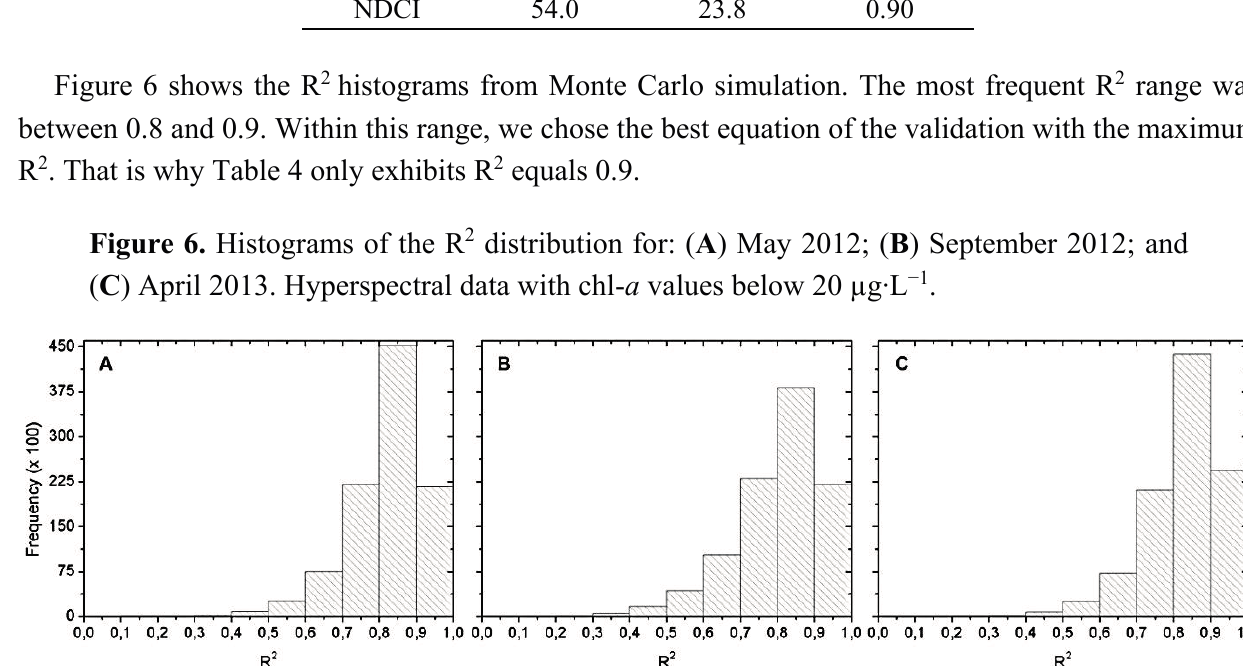
Table 4. Coefficients derived from model calibrations applied to samples with chl- a concentration bellow 20 µg·L − 1 . Hyperspectral data. Slope Intercept R² 2BDA 41.8